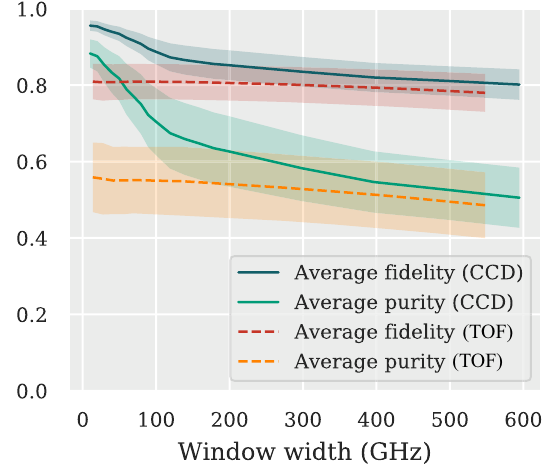
FIG. 10. Average selectivity of a MQPG-based decoder for different dimensionalities as a function of the ratio between the maximum available pump bandwidth ( (cid:13)ν pump ) and the band- width of the phase-matching function ( (cid:13)ν PM ). The cross marks the conditions of the experiment presented in the main text, whereas the dashed line shows what can be achieved with state- of-the-art components (a 10-cm-long sample and a pump laser bandwidth of 13